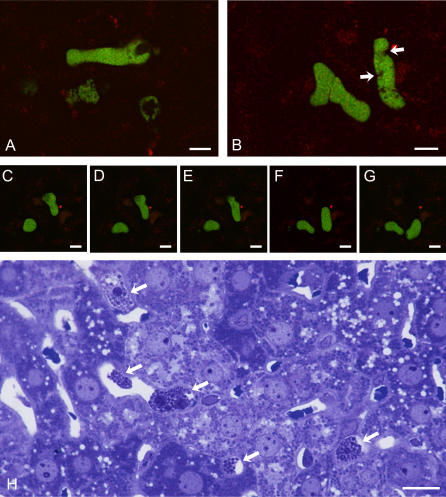
Dynamics of Merosome Transport in the Liver(A) Multiple merosomes separate from an EEF and are rapidly transported towards the central vein (see Video S6). Bar = 10μm.(B) Large merosomes move slowly within the sinusoidal lumen (see Video S7). Remnant bodies can be differentiated from merozoites by their larger size and lack of GFP (arrows). Bar = 10 μm.(C–G) Individual frames of an intravital confocal video showing two smaller merosomes gliding along a sinusoid. Bars = 10 μm.(H) Semithin liver section 52 h after infection with P. yoelii. Multiple merosomes, presumably released from a single EEF, can be found inside the sinusoids (arrows). Note the presence of remnant bodies in merosomes. Bar = 10 μm.